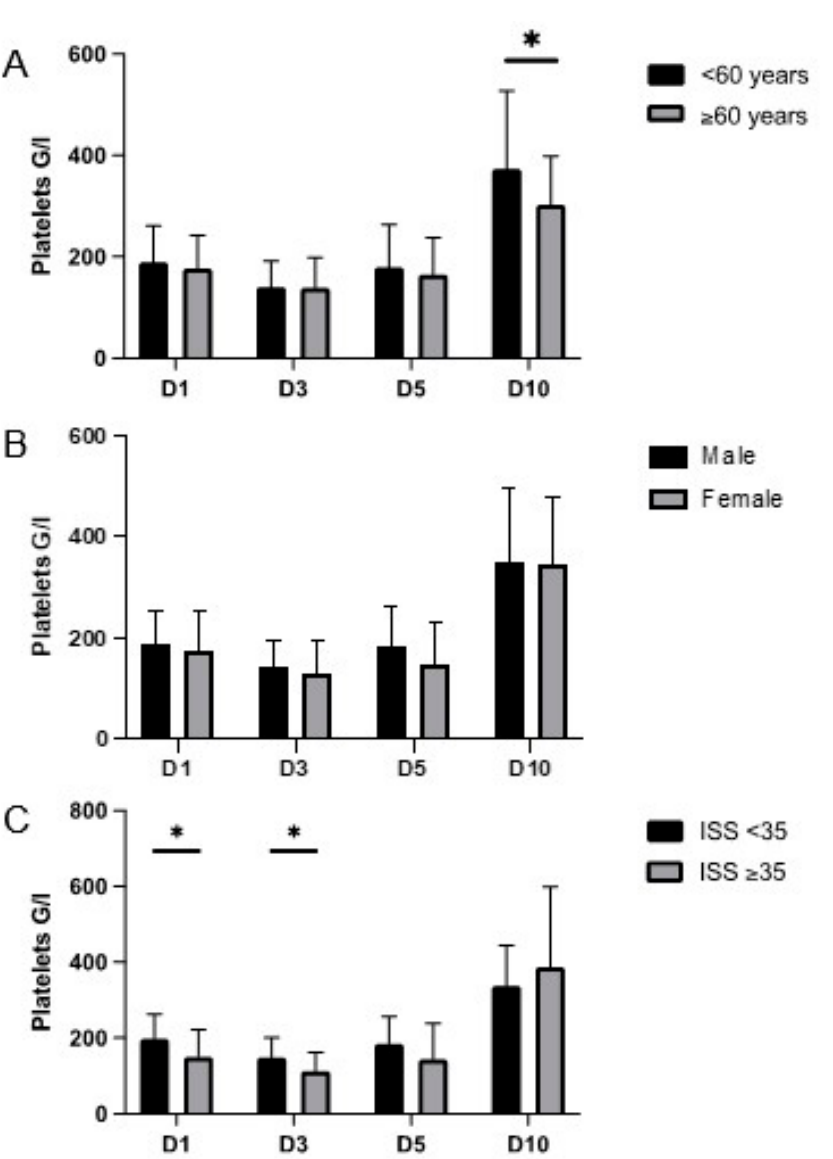
Figure 2. Platelet concentrations on days (D) 1, 3, 5, and 10 in the subgroups age ( A ), gender ( B ), and injury severity ( C ). Data are presented as mean and standard deviation. Concerning age, there was a significant increase in platelet counts in patients younger than 60 years compared to older individuals on D10 ( p = 0.039). There were no significant differences between male and female patients. Platelet counts in patients with an ISS ≥ 35 were significantly decreased on D1 ( p = 0.012) and D3 ( p = 0.011) compared to patients with lower injury severity. * = p <